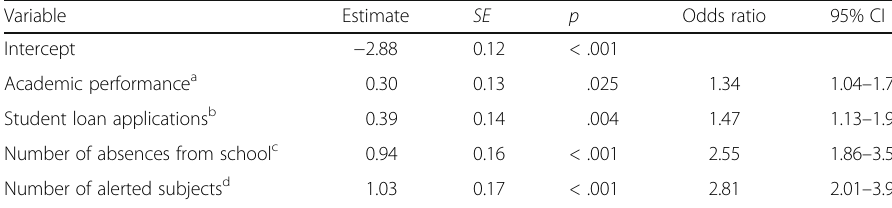
Table 2 Logistic regression analysis